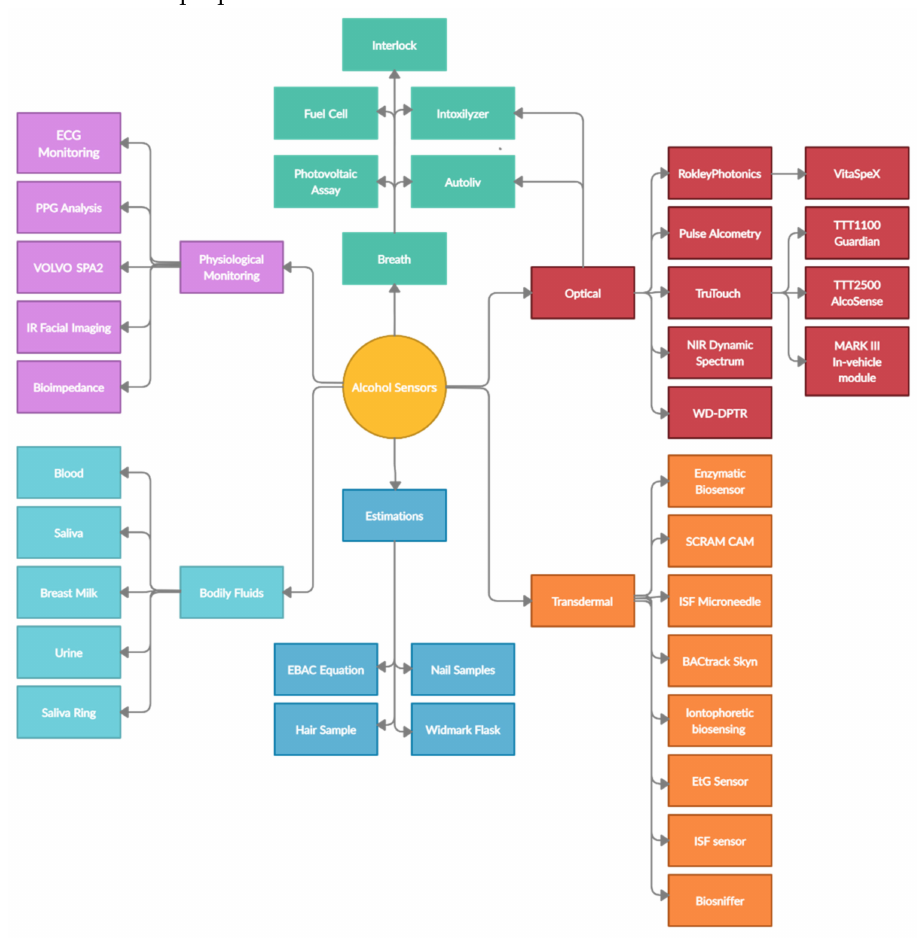
Figure 5. Alcohol sensing technologies by type of